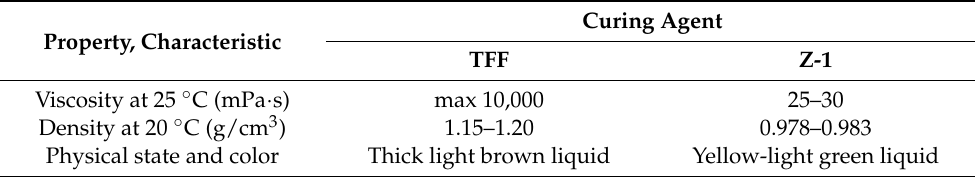
Table 2. Properties and characteristics of curing